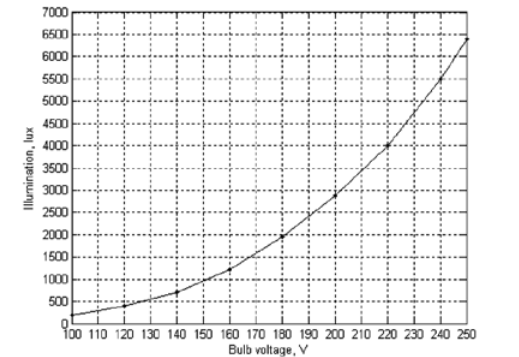
Fig. 6. Typical sensitiveness of the photodetector against